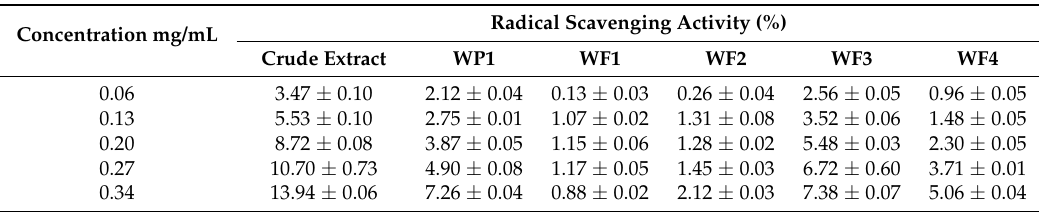
Table 3. 1-diphenyl-2-picrylhydrazyl (DPPH) radical scavenging activity (%) of W. globosa extract at different